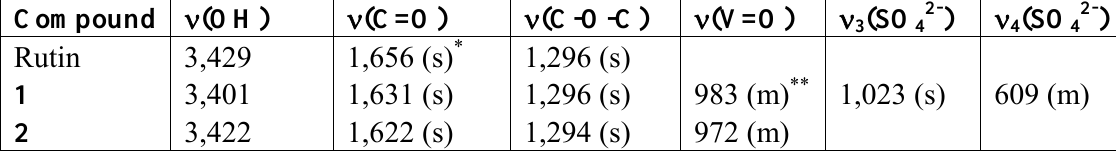
Table 1. Selected absorption maxima (cm -1 ) for rutin and